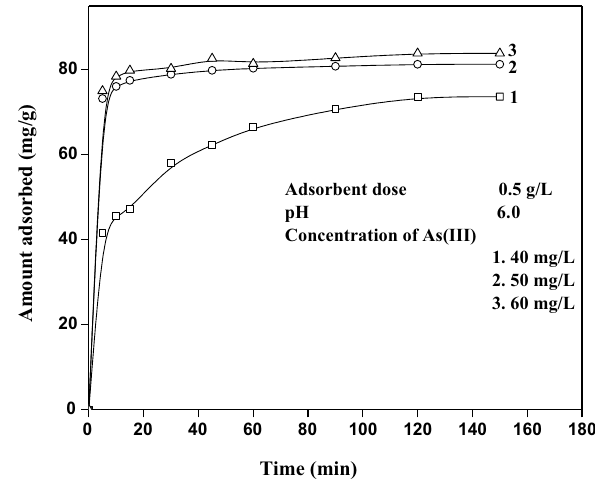
Fig. 2 Effect of contact time and initial concentration